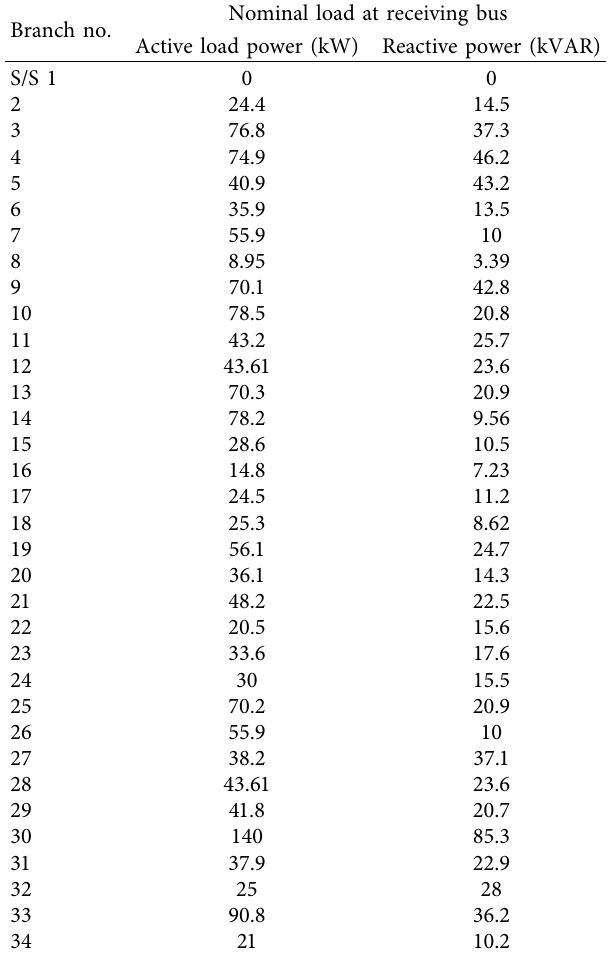
Table 4: Bus data for radial distribution system. Branch